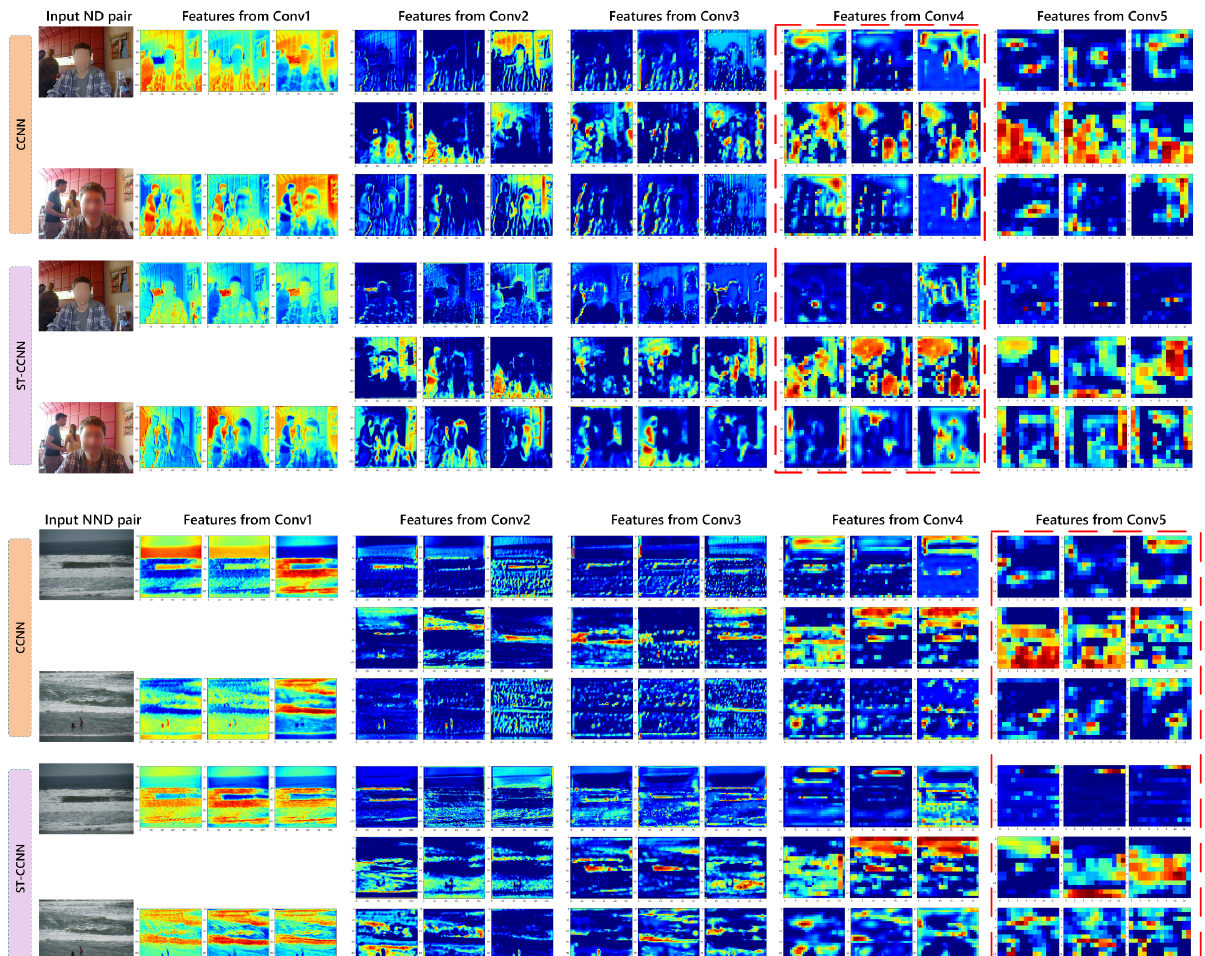
Figure 9. Visualization of the first three slices feature maps on each convolutional set of networks with/without the ST modules. For the ND pair, as shown highlighted by red dashed box, cross stream feature maps of ST-CCNN are more concentrated in the identical regions with slight displacements and zooming of the ND pair. For the NND pair, the feature maps in image streams show more obvious discrimination and the feature maps slices in the cross stream capture more saliency regions of each image in the NND pair, which can provide greater capacity for accurate decisions on challenging